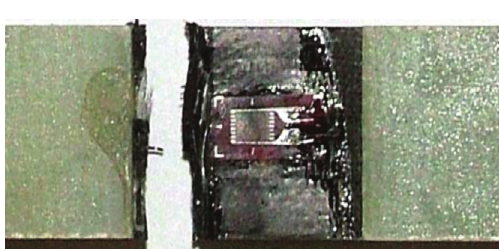
Figure 23: Comparison between predicted and experimental failure locations for the tensile tests.